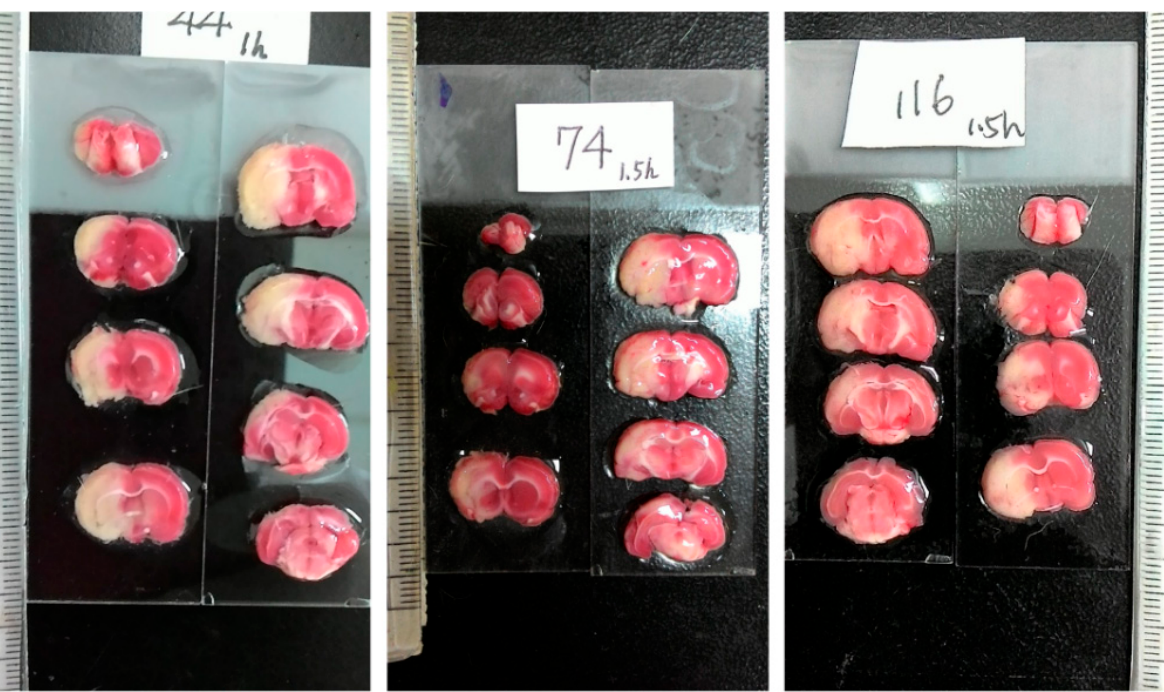
Figure 1. Representative examples of three camera-based TTC-stained rat brain images (900 × 1600) after ischemic stroke captured by a smartphone. Each image represents an individual rat subject with the MCAO model. Each image includes eight different rat brain slices, where the massive white regions indicate infarction.